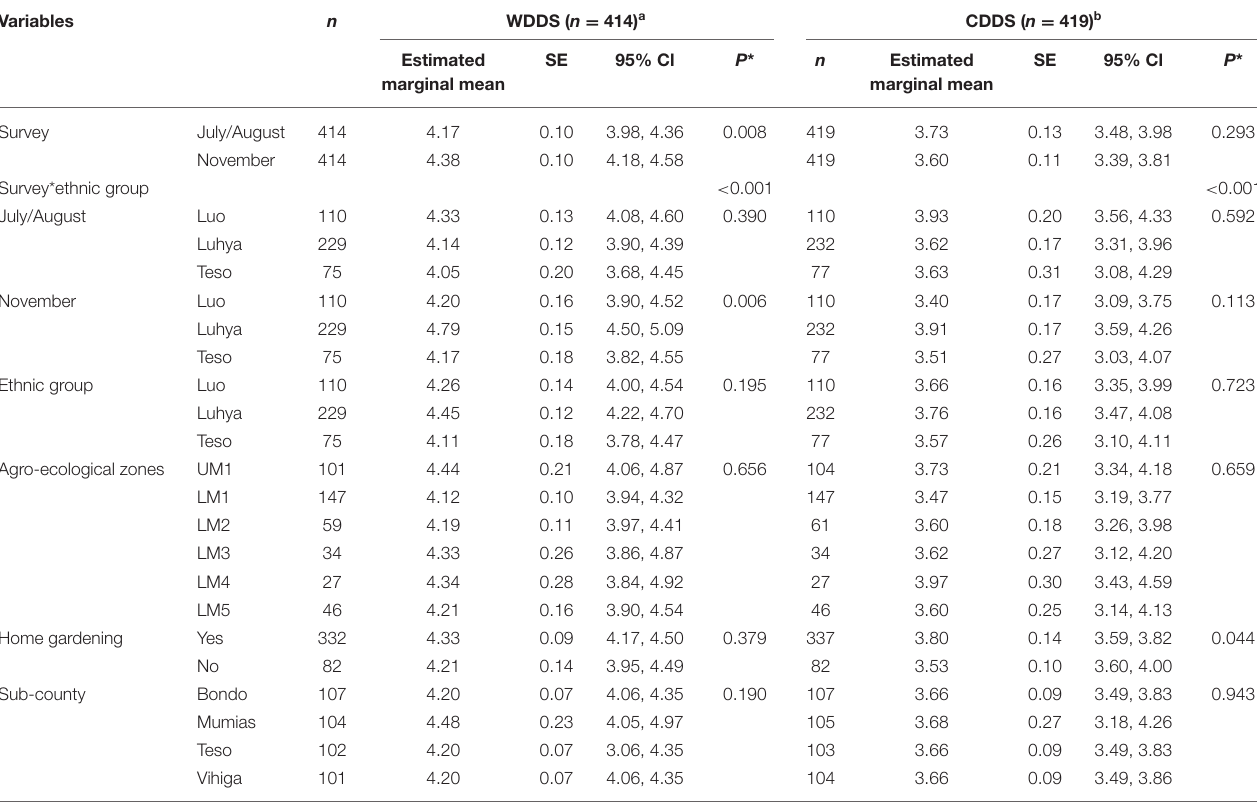
Estimated SE 95% Cl P * n Estimated SE 95% Cl P * marginal mean marginal mean